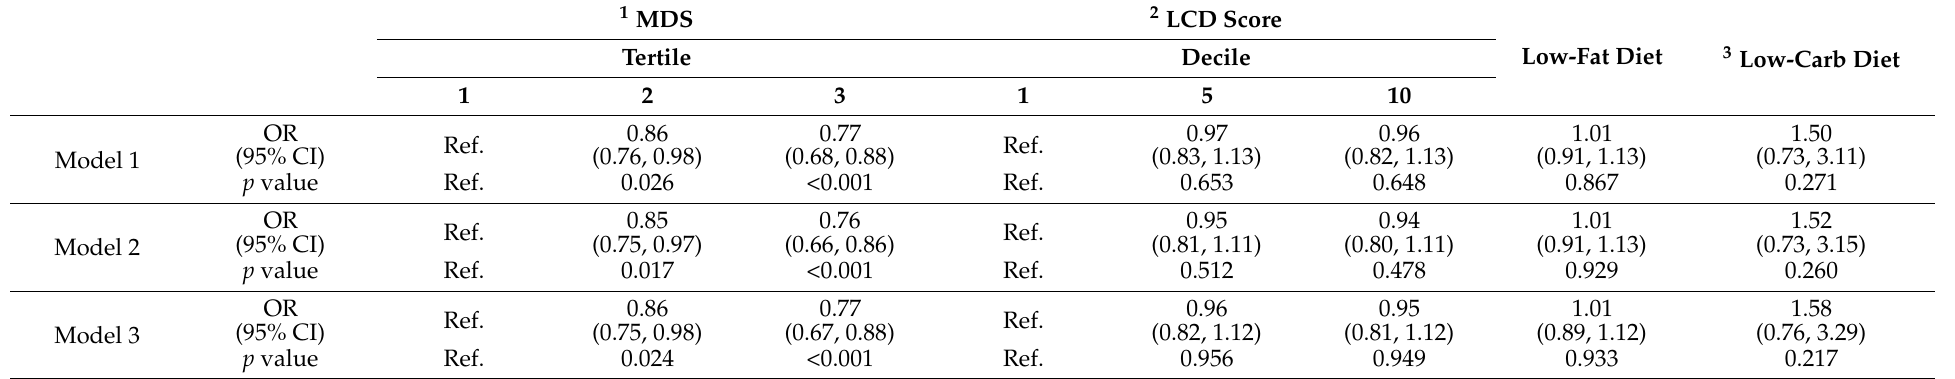
Table 3. Odds ratios (95% confidence intervals) for lowest quartile of serum Klotho levels (represents aging) in various dietary patterns. 1 MDS 2 LCD Score